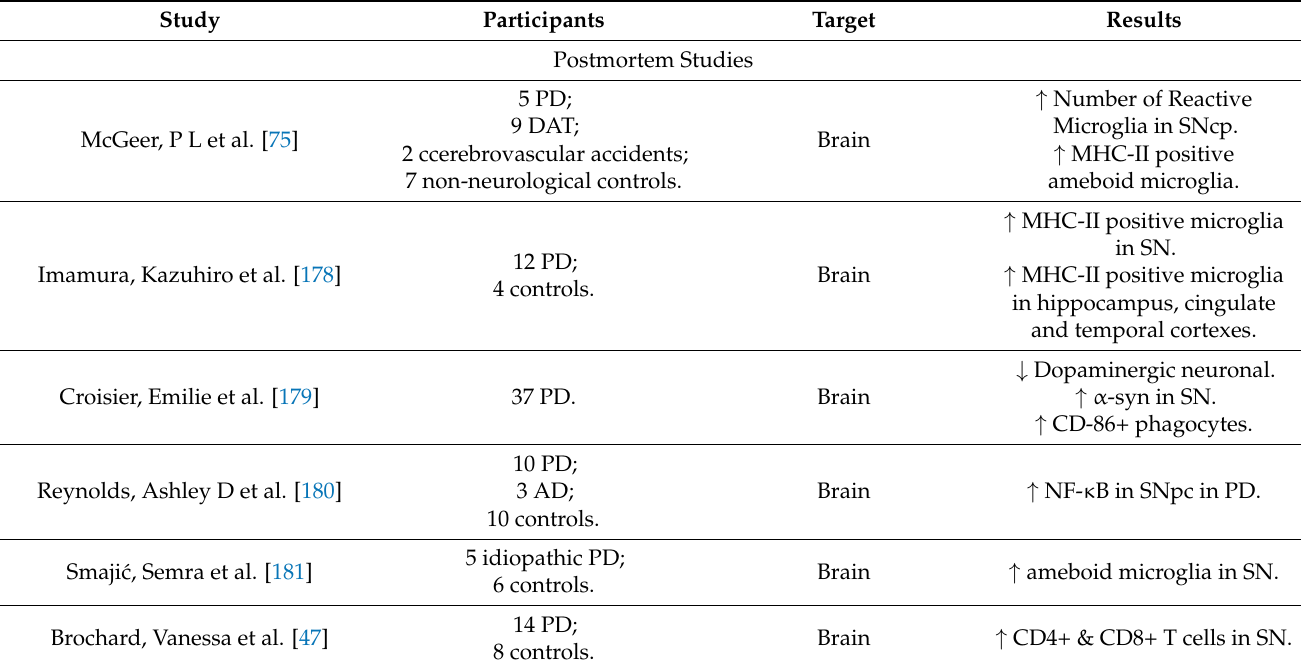
Table 1. Human studies as evidence for microglia-mediated neuroinflammation in PD. Increase ( ↑ ), decrease ( ↓